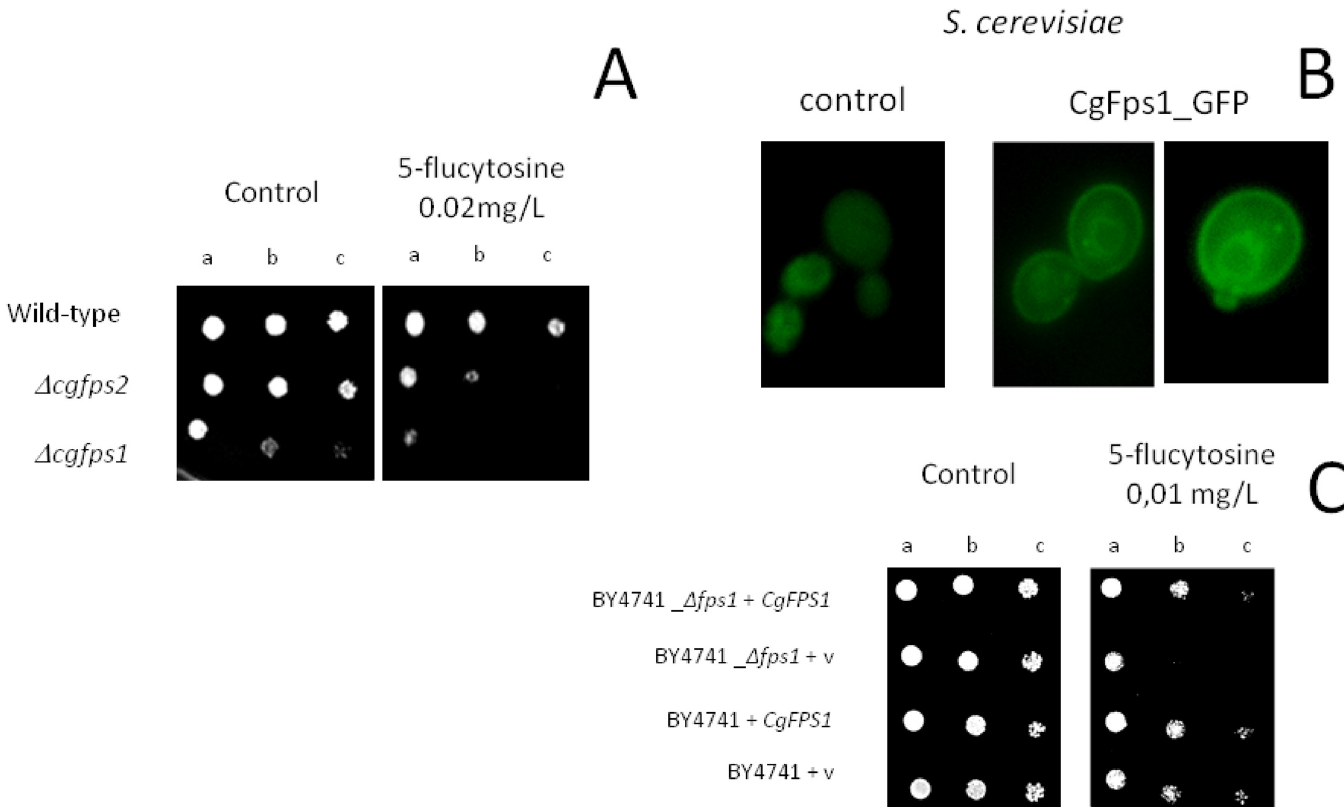
Fig 4. The acquaglyceroporins CgFps1 and CgFps2 confer resistance to 5-flucytosine. A) Comparison, by spot assays, of the susceptibility of the C . glabrata KUE100, KUE100_ Δ cgfps1 and KUE100_ Δ cgfps2 strains (B) to 5-flucytosine, in MMB agar plates. B) Fluorescence of exponential-phase BY4741 S . cerevisiae cells, harboring the cloning vector pGREG576 (control) or the pGREG576_ CgFPS1 plasmids (CgFps1_GFP), after 5h of galactose-induced recombinant protein expression. C) Comparison, by spot assays, of the susceptibility to 5-flucytosine of S . cerevisiae BY4741 and BY4741_ Δ fps1 cells, harboring the cloning vector pGREG576 (v) or the same plasmid expressing the CgFPS1 gene, in MMB agar plates. In A) and C) the inocula were prepared as described in Materials and Methods, and the cell suspensions used to prepare the spots 1:5 (b) and 1:25 (c) dilutions of the cell suspension used for column a. The images are representative of at least three independent